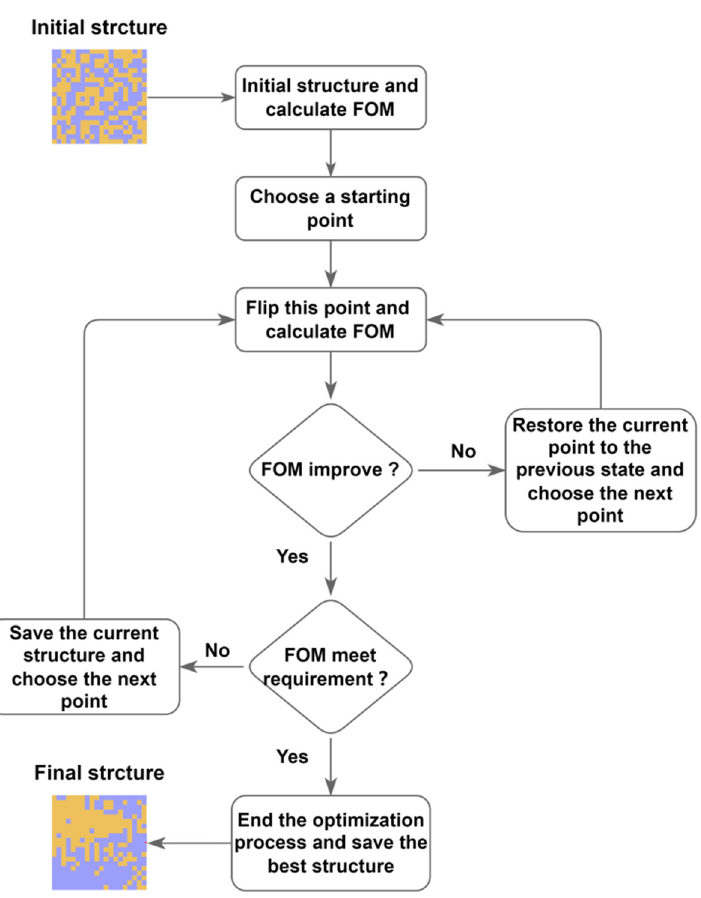
Figure 2. Flow chart of the DBS algorithm. First, a random structure is initialized, and the points in the structure are flipped point by point and the FOM was calculated. The structure with a higher FOM will be saved, iterating until the stop requirements were met.